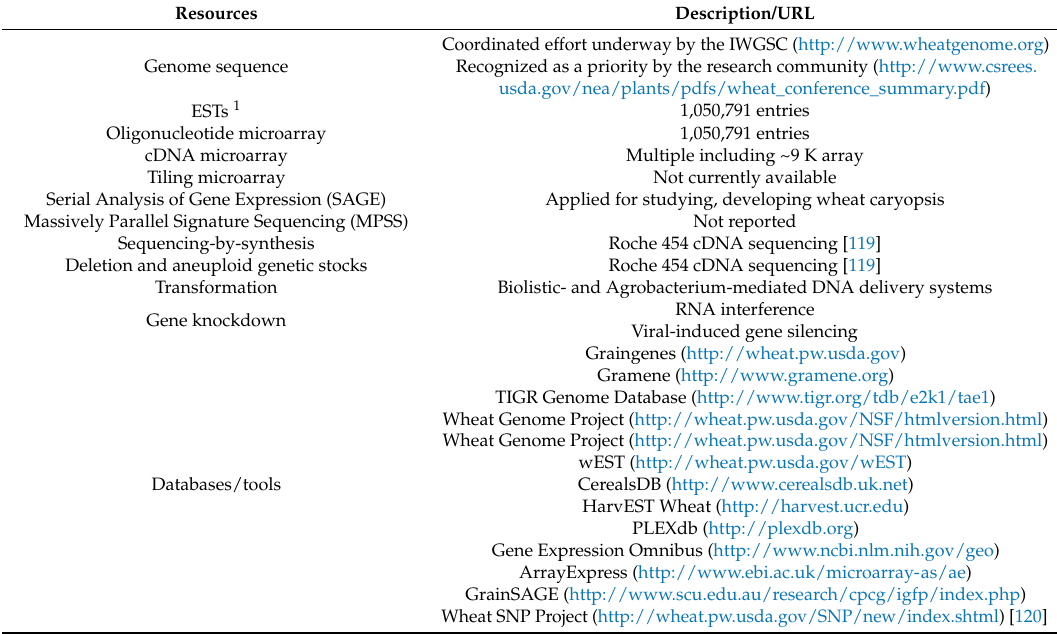
Table 3. Online transcriptomics resources in